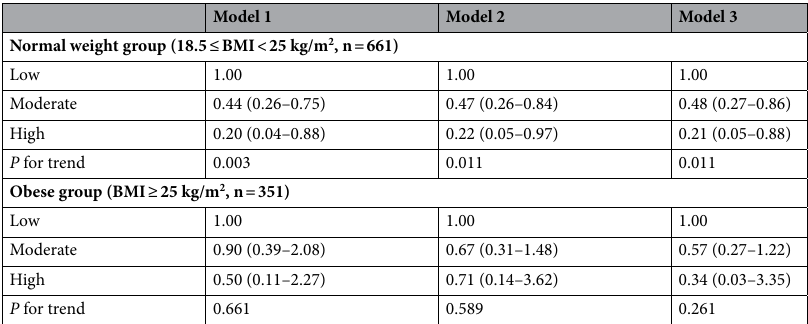
Table 4. Association of physical activity level with dynapenia in groups by obesity status. Data are odds ratios (95% confidence interval). BMI, body mass index. Model 1: adjusted for age and sex. Model 2: based on model 1, further adjusted for BMI, smoking, alcohol, education, hypertension, diabetes, anemia, asthma, cardiovascular disease, depression, and total calorie intake. Model 3: based on model 2, further adjusted for Global Initiative for Chronic Obstructive Lung Disease (GOLD)